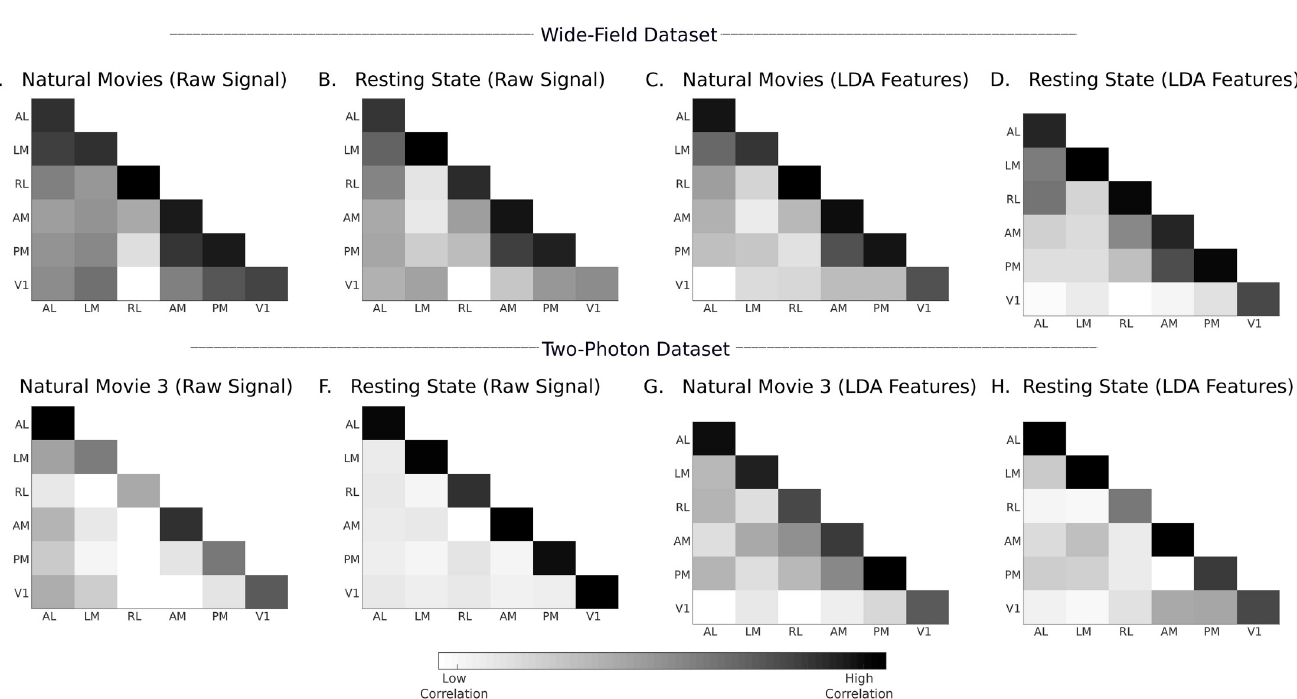
Fig 8. Intra-area and inter-area correlations computed on input responses and LDA features. A – D ) Correlations computed from mouse M4 of wide-field dataset. E – H ) Correlations computed from Emx1-IRES Cre-line of two-photon dataset. The correlations are computed as averages over all unique pairs of neurons/pixels in the test data, which were not used to train the LDA projection matrix. The correlations in the two-photon dataset are computed using data pooled from different mice and multiple sessions. In S3 and S4 Figs, we present a detailed correlation analysis with information about individual mice and session. Further examples of correlations analysis are shown in S5–S7